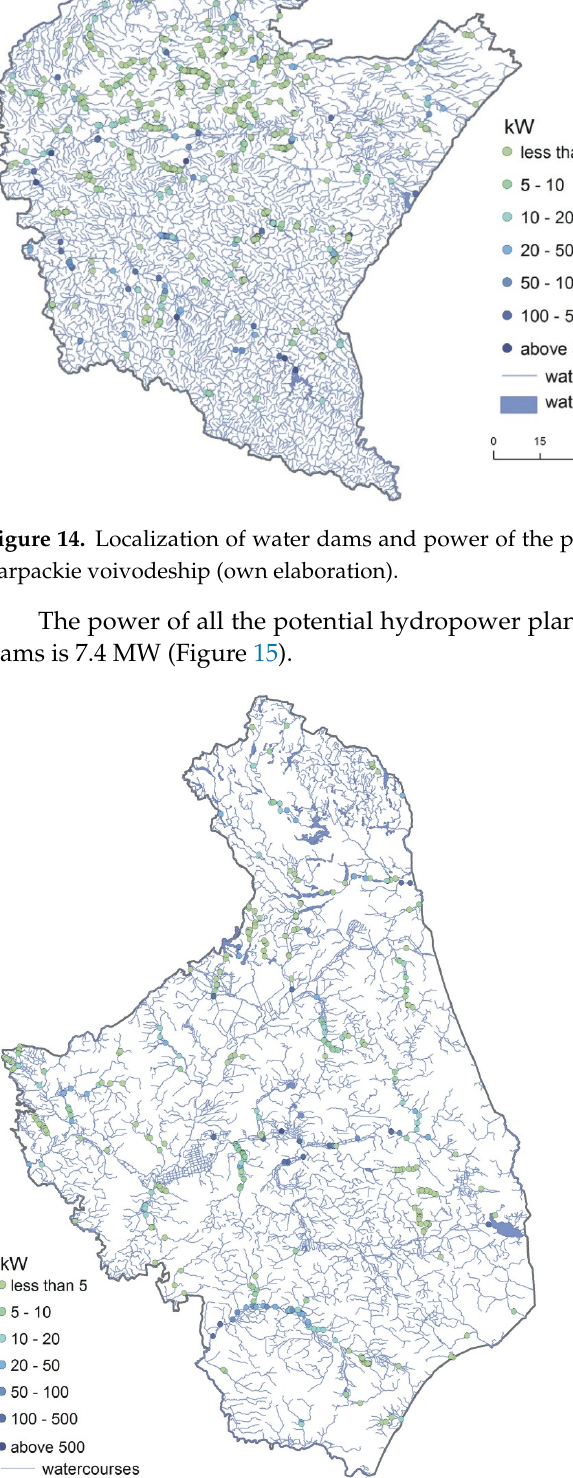
Figure 15. Localization of water dams and power of the potential hydropower plants in the Podlaskie voivodeship (own elaboration). The power of all the potential hydropower plants in the Pomorskie voivodeship on dams is 20.0 MW (Figure 16).